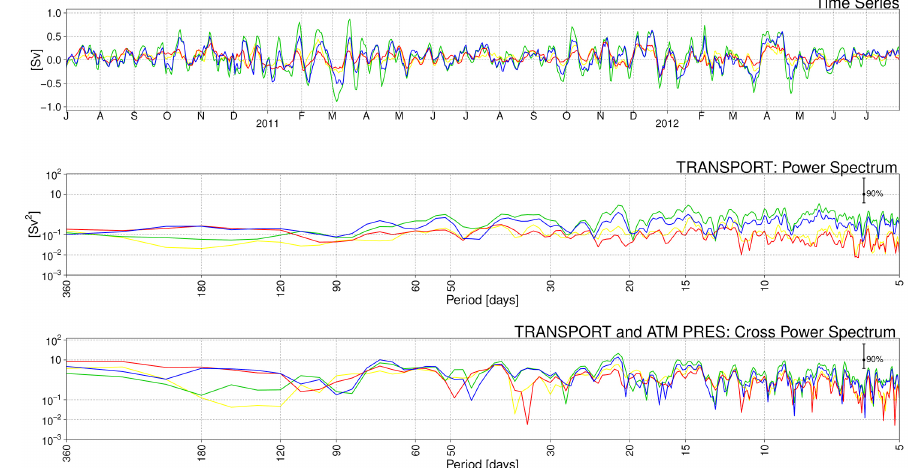
Figure 4. Top panel: Gibraltar transport time-series from the four experiments. Middle panel: Gibraltar transport power spectra. Bottom panel: cross power spectrum between Gibraltar transport and atmospheric pressure. NEMO-MFS1, red; NEMO-MFS2, blue; NEMO-MFS3, yellow; NEMO-MFS4,